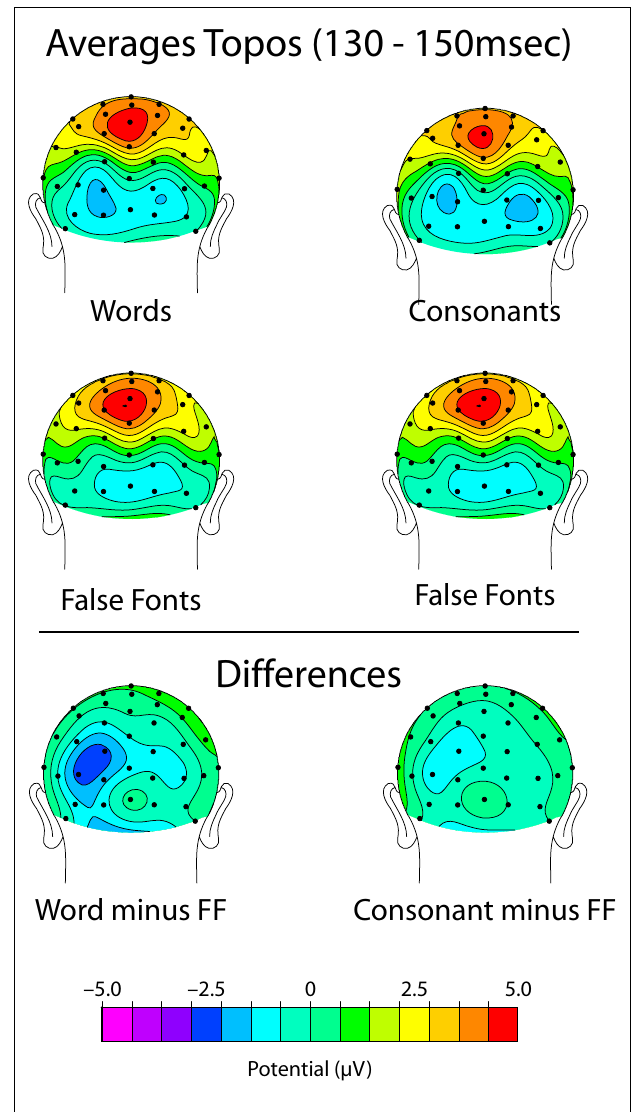
FIGURE 2 | ‘LOcc140’ results. Topographic distributions, shown from a posterior perspective, of the mean activity from 130–150 ms for Words (top left), Consonants (top right), False Fonts (middle), and their Differences (Words minus False Fonts on bottom left and Consonants minus False Fonts on bottom